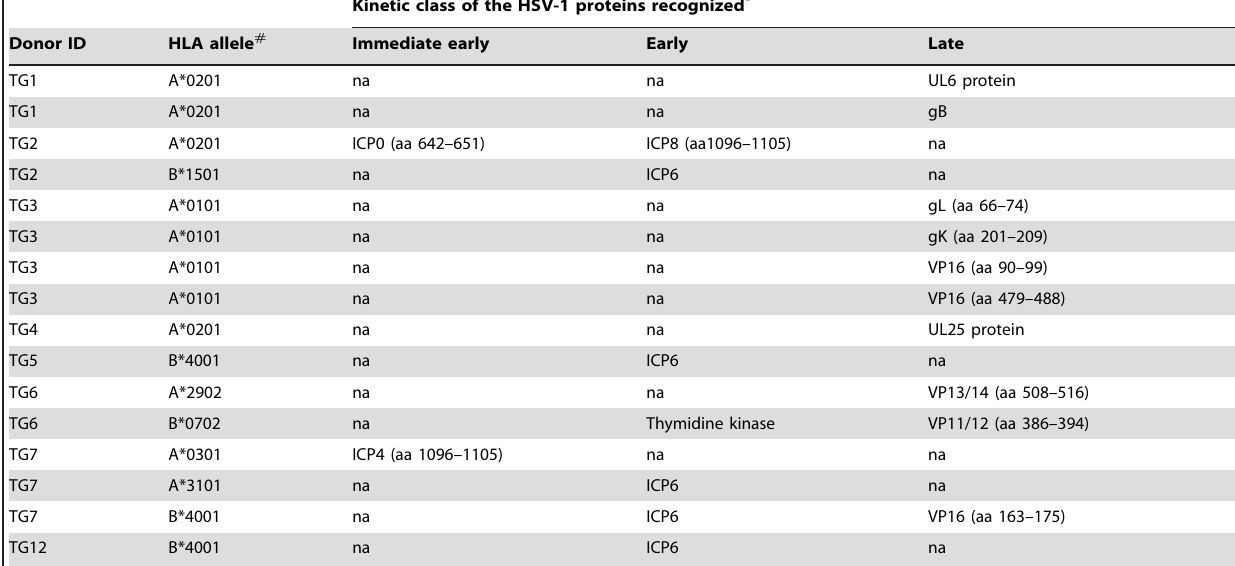
Kinetic class of the HSV-1 proteins recognized